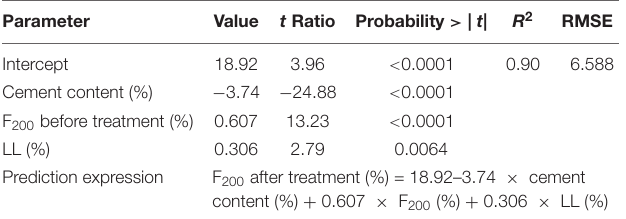
TABLE 2 | Multi-variate analysis results to predict F 200 after cement stabilization.